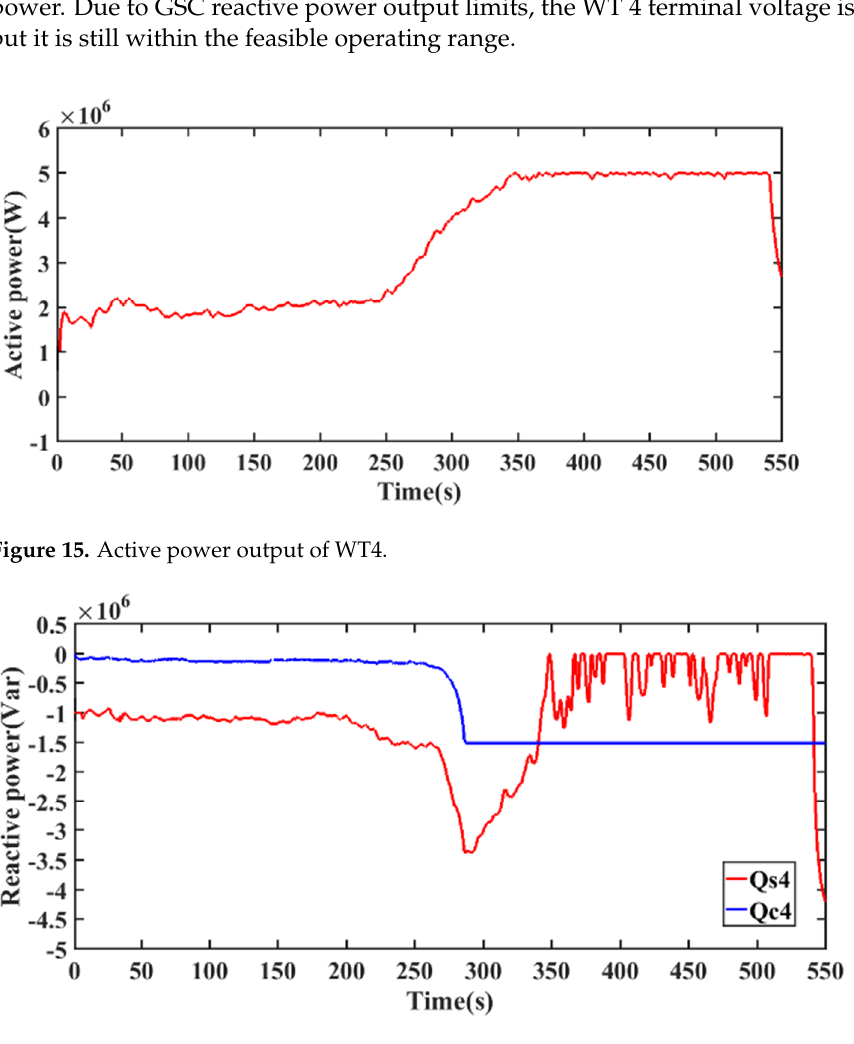
Figure 14. Voltage of WT4.